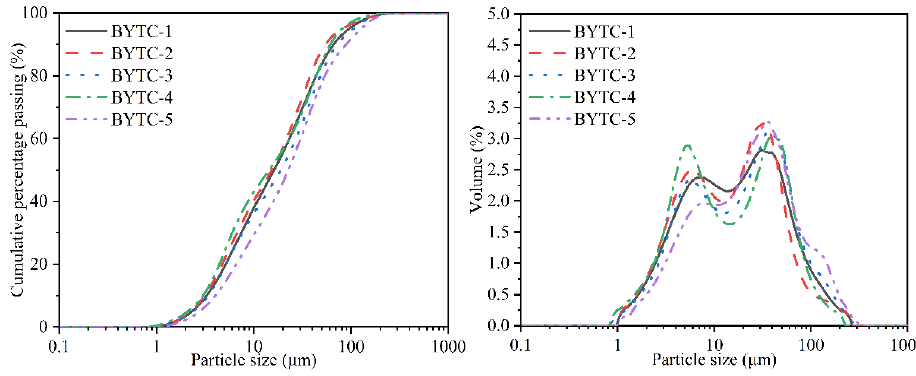
Figure 1. Particle size distribution of the BYT cement powder.